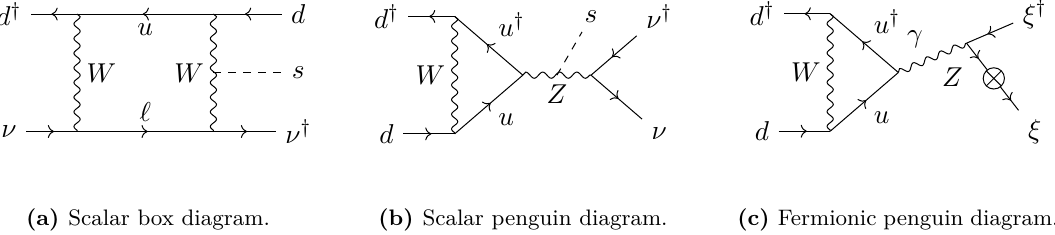
Figure 7. One-loop portal diagrams for some of the portal operators. Panels a and b depict contributions to the scalar portal operator (3.18b), where the scalar field can couple to any of the heavy EW bosons. Panel c depicts the contribution to the fermionic portal operator in (3.21).